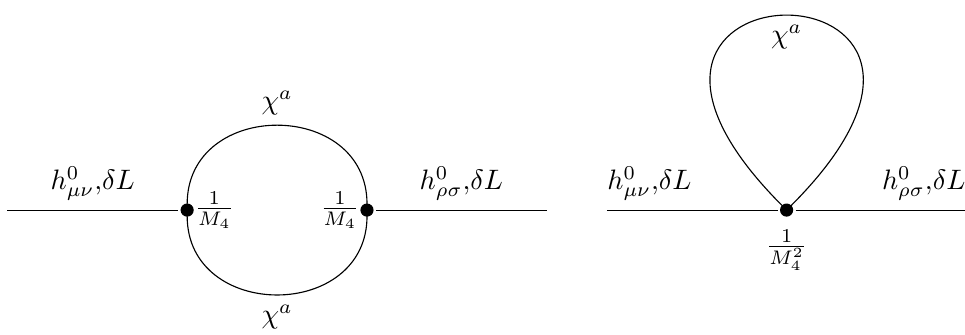
Figure 1 . Self-energy diagrams correcting the propagator of the massless 4d graviton and the volume modulus. The 3-vertex is suppressed by 1 /M 4 and the 4-vertex by 1 /M 2 symbolizes all fields with their KK towers, including the massless moduli and ghost